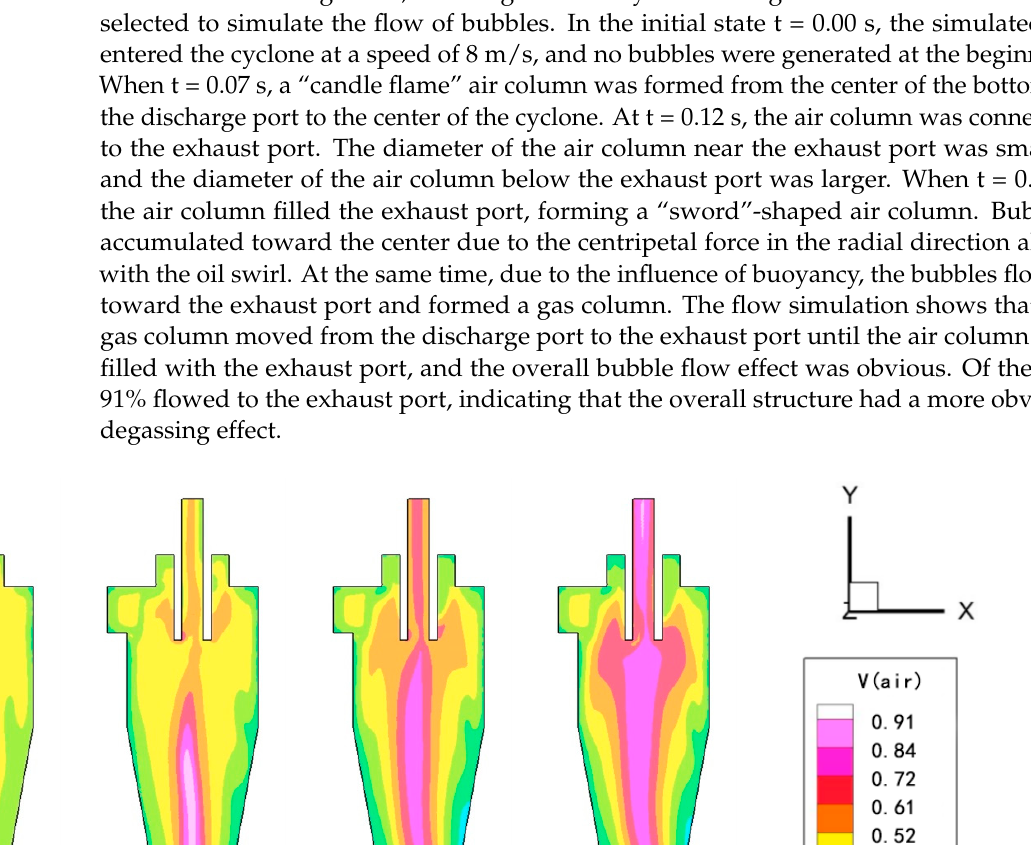
Table 2. Performance parameters of three-screw pump.